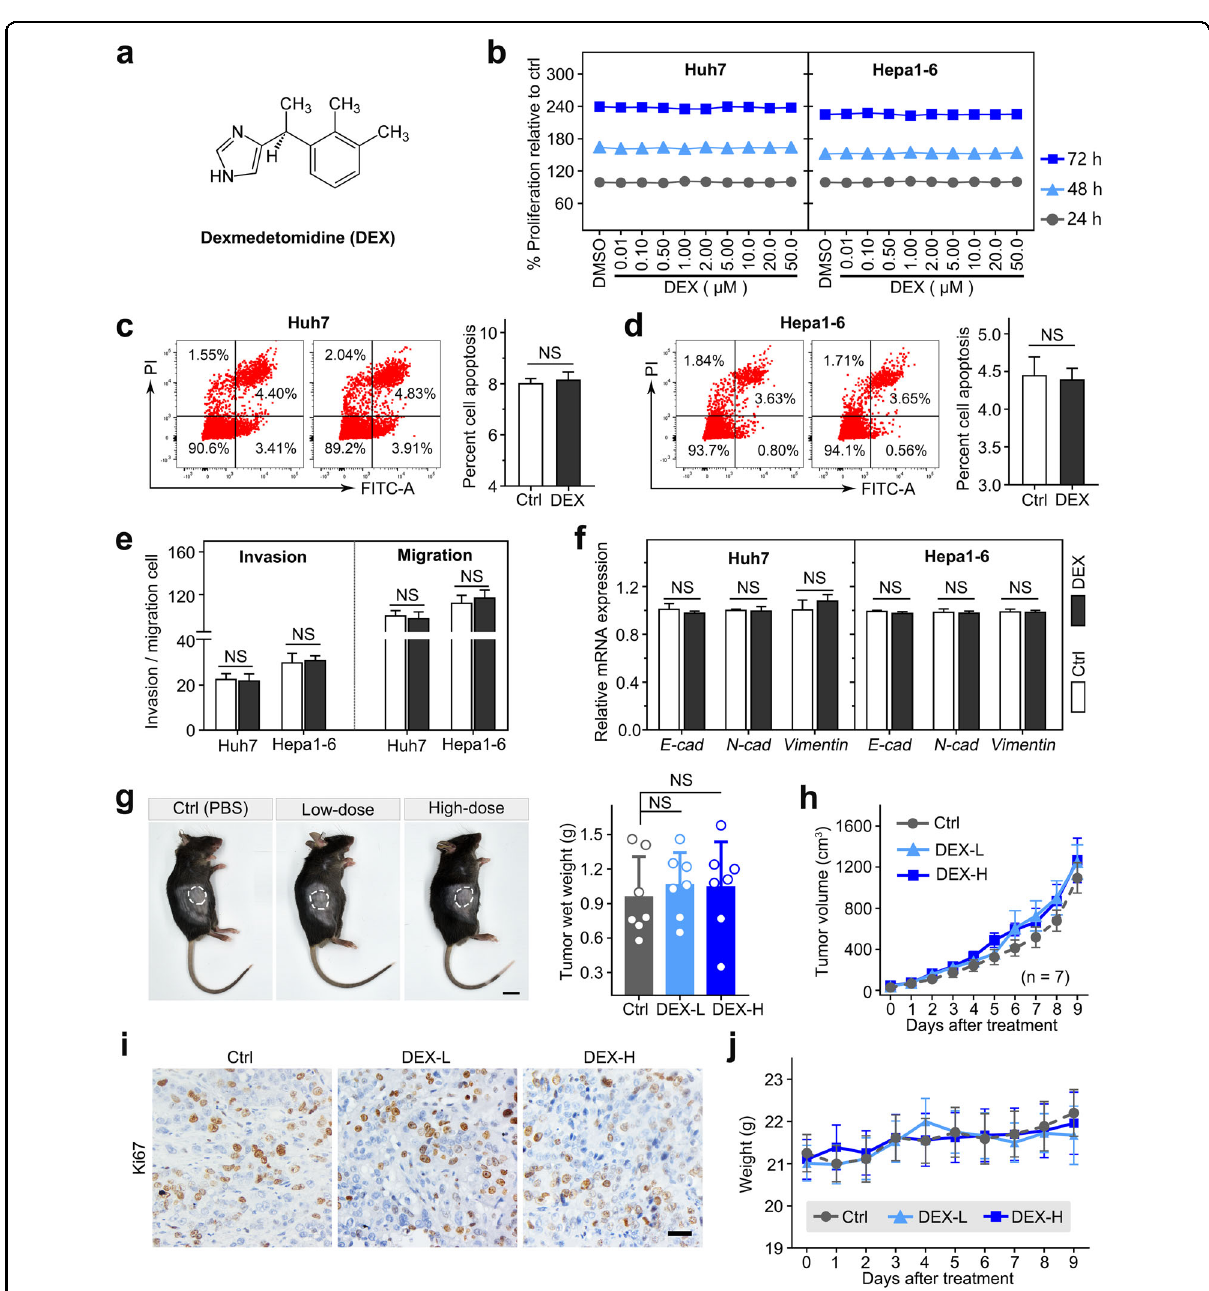
Fig. 3 DEX did not exert signi fi cant effects on the biological behaviors of HCC in vitro or in vivo. a The molecular formula of DEX. b Cell viability of Huh7 and Hepa1 – 6 cells treated with DEX for 24, 48, and 72 h. c , d Huh7/Hepa1 – 6 cells were stained with FITC-conjugated annexin V and PI after DEX treatment and monitored using fl ow cytometry. e The invasion/migration ability of Huh7/Hepa1 – 6 cells in the presence of DEX (10 μ M). f The mRNA level of EMT-related biomarkers in Huh7/Hepa1 – 6 cells treated with DEX (10 μ M). g Representative gross image of mice from the indicated groups (left panel). Histogram analysis of the weight of tumors harvested at the end point (right panel). h The tumor volume [(length × width 2 )/2] after treatment of mice with vehicle or DEX (L, low: 5 μ g/kg; H, high: 10 μ g/kg). Data are presented as the mean ± SEM. i Ki67 IHC staining was performed in HCC tissue. j Mouse body weight during DEX treatment. Data are presented as the mean ± SD. NS not signi fi